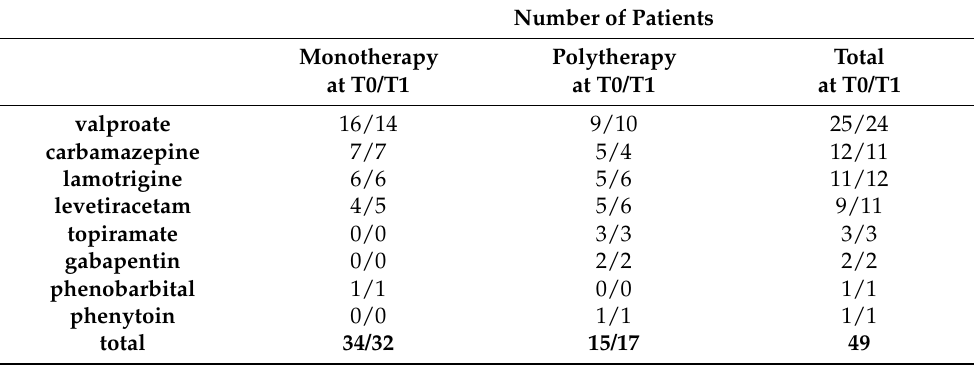
Table 8. Clinical characteristics of the